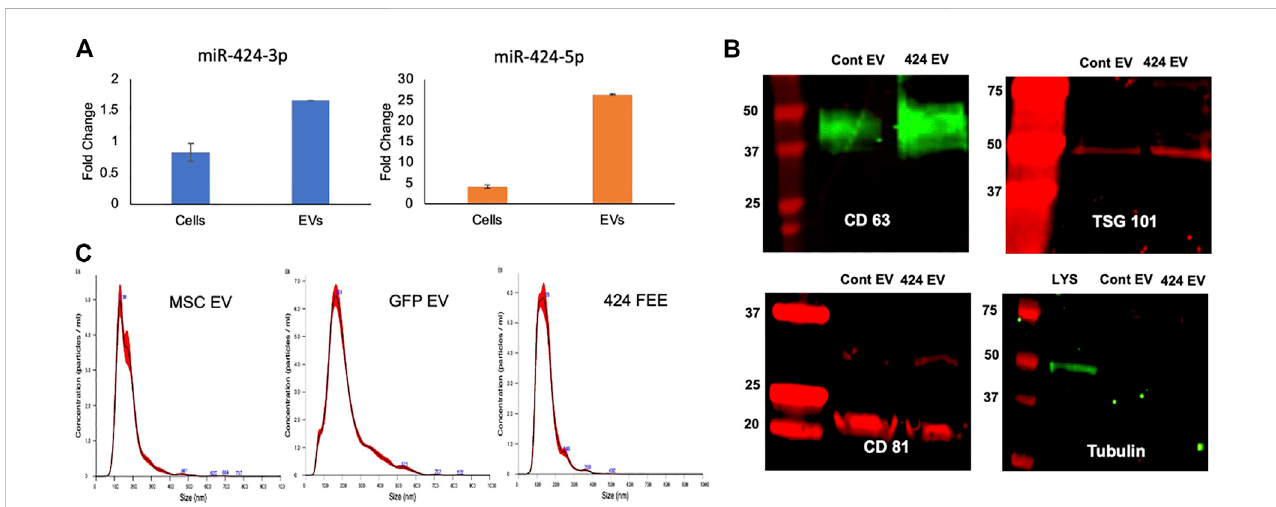
FIGURE 1 Characterization of the engineered EVs. (A) Fold change in the expression levels of the 3p and 5p strands of miR-424 in cellular extracts and EV extracts. Data show mean fold change ( ± SD) in expression with respect to vector controls. (B) Immunoblots of EV membrane proteins CD63 and CD81 and Intra EV proteinTSG101incontrol andengineered EVs.Tubulinwasusedas acontrolfor absenceofcellular proteinintheEVlysates. Notetheexpressionoftubulinin thecellularlysate(LYS)andnotintheEVlysates. (C) NTA plotsofEVsizedistributionindicating that nosigni fi cant changeoccurred inEVsizedistribution in control and engineered EVs compared to naïve MSC